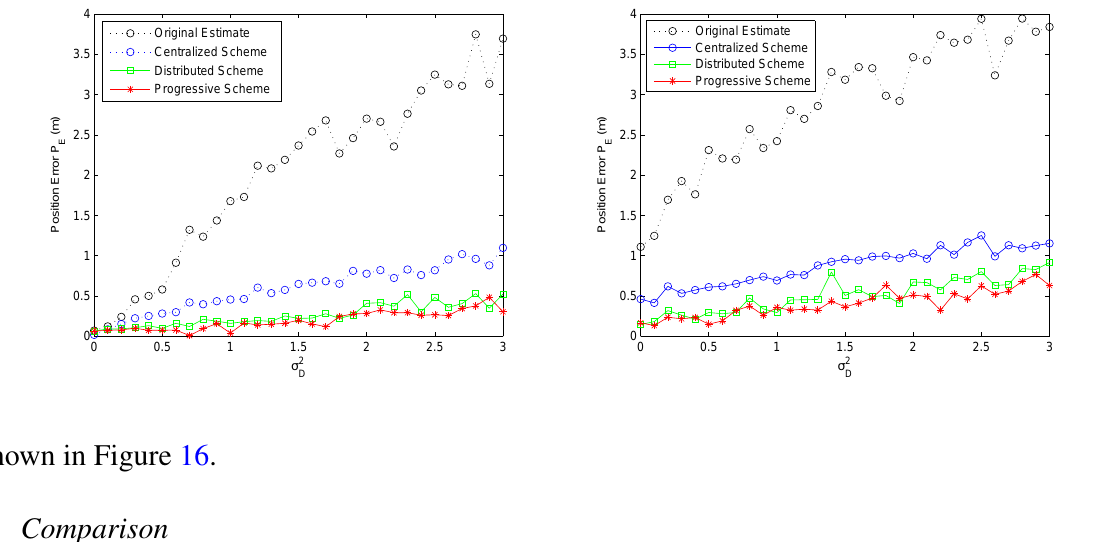
= 0 . 01 (left) and σ 2 = 1 P P − P m || for sensor m = || P m E true estimate